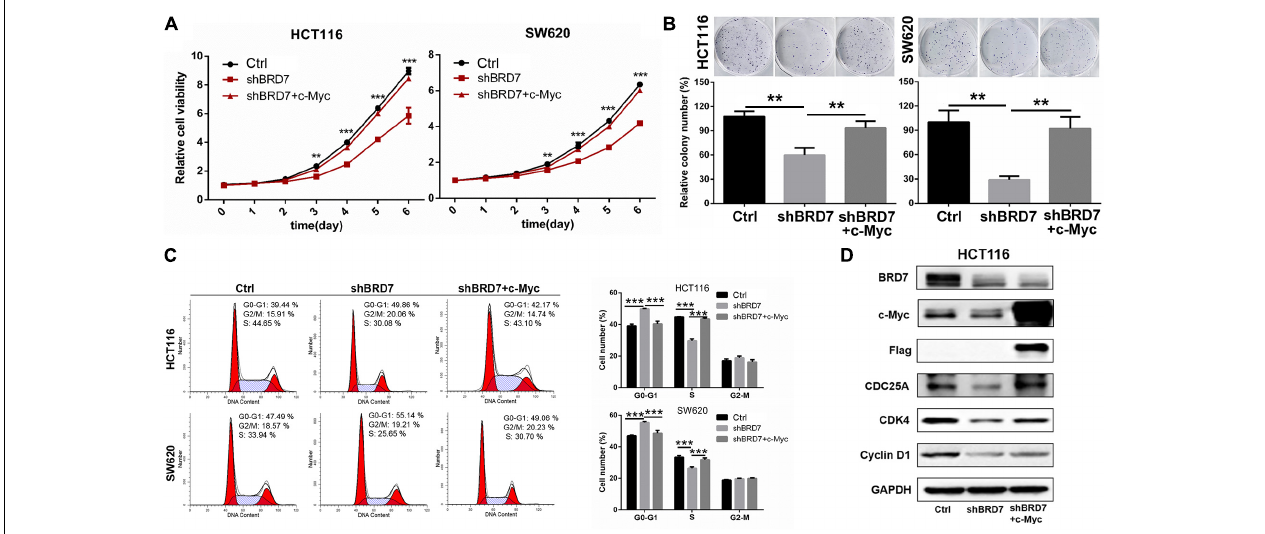
FIGURE 5 | Restoring the expression of c-Myc reverses BRD7 knockdown-induced effects on cell proliferation and cell cycle progression in colorectal cancer (CRC) cells. (A) The effect of restoring c-Myc expression on BRD7 knockdown-induced cell proliferation inhibition, (B) cell colony formation, and (C) cell cycle G1/S phase arrest. (D) Western blotting confirmed the key molecules regulated by the BRD7/c-Myc axis. The results are presented as the mean ± SD. ** P < 0.01, *** P <